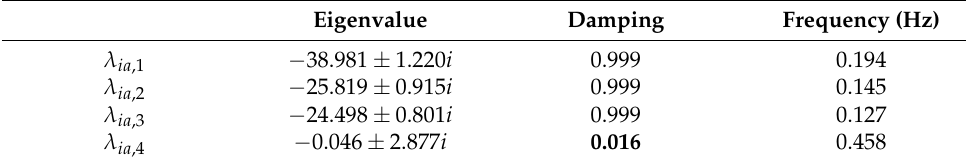
Table 2. Inter-area modes (scenario A). Bold values highlight critical damping.